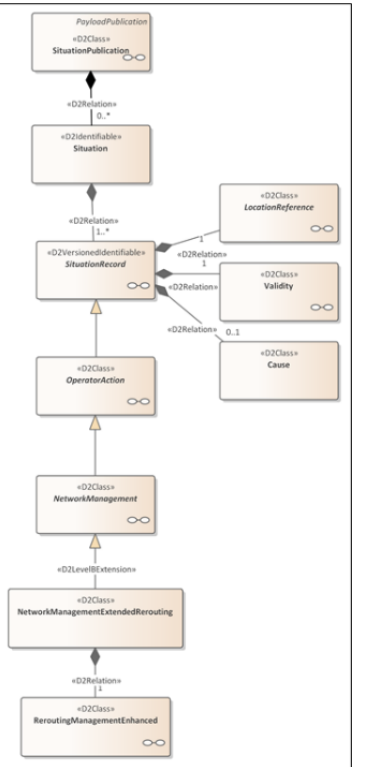
Figure 3. Embedding ReroutingManagementEnhanced into DATEX II situation model.